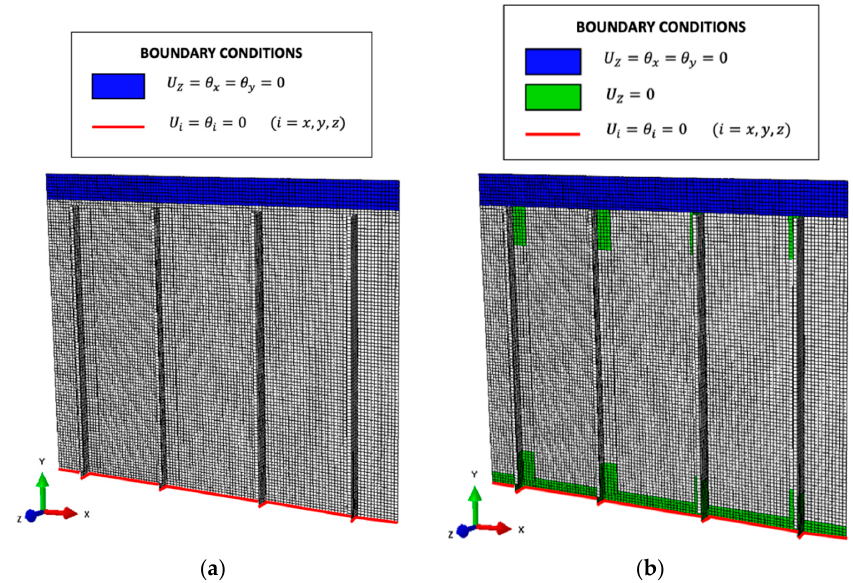
Figure 9. Simplified iFEM models: ( a ) Model 1 with base boundary conditions; ( b ) Model 2 with high stiffness boundary conditions.